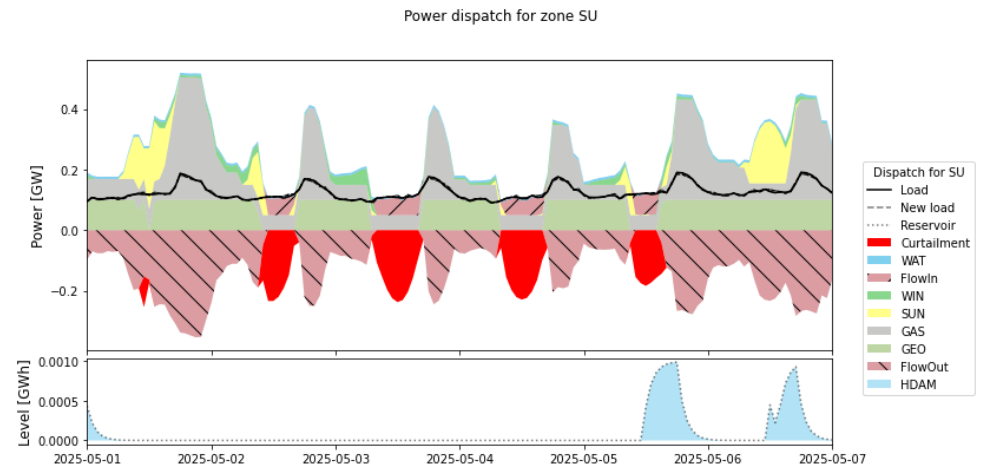
Figure 29. Moderate Penetration Scenario 1(NH)—zone south (1–7 May 2025).